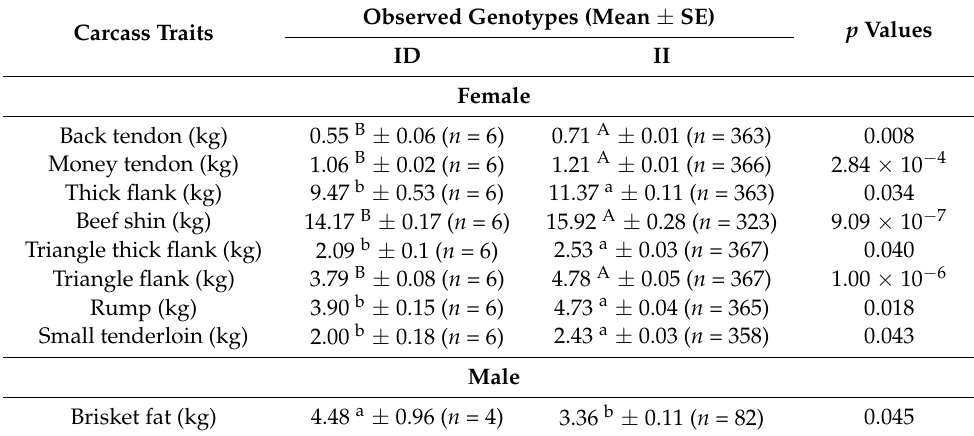
Table 7. Associations of the P2-Del-8-bp InDel with carcass traits in different genders of the SDBCGR population.